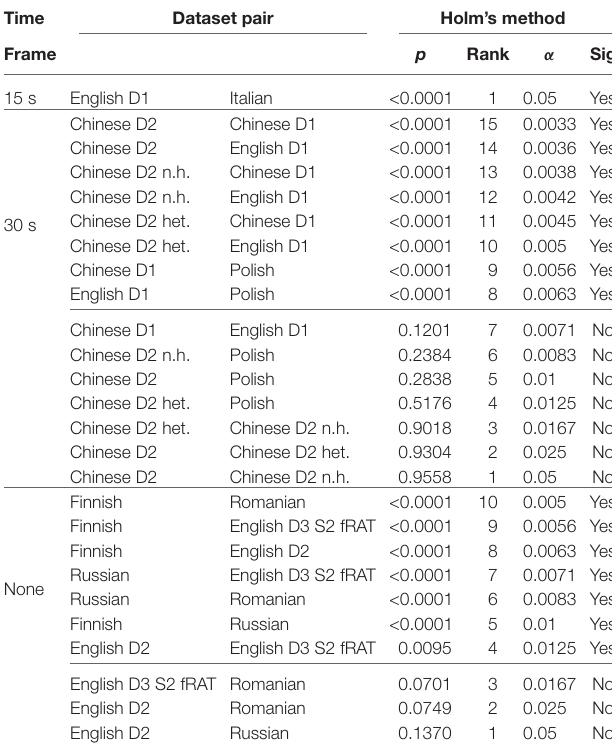
TABLE 3 | Results of Mann-Whitney testing with Bonferroni-Holm correction regarding the